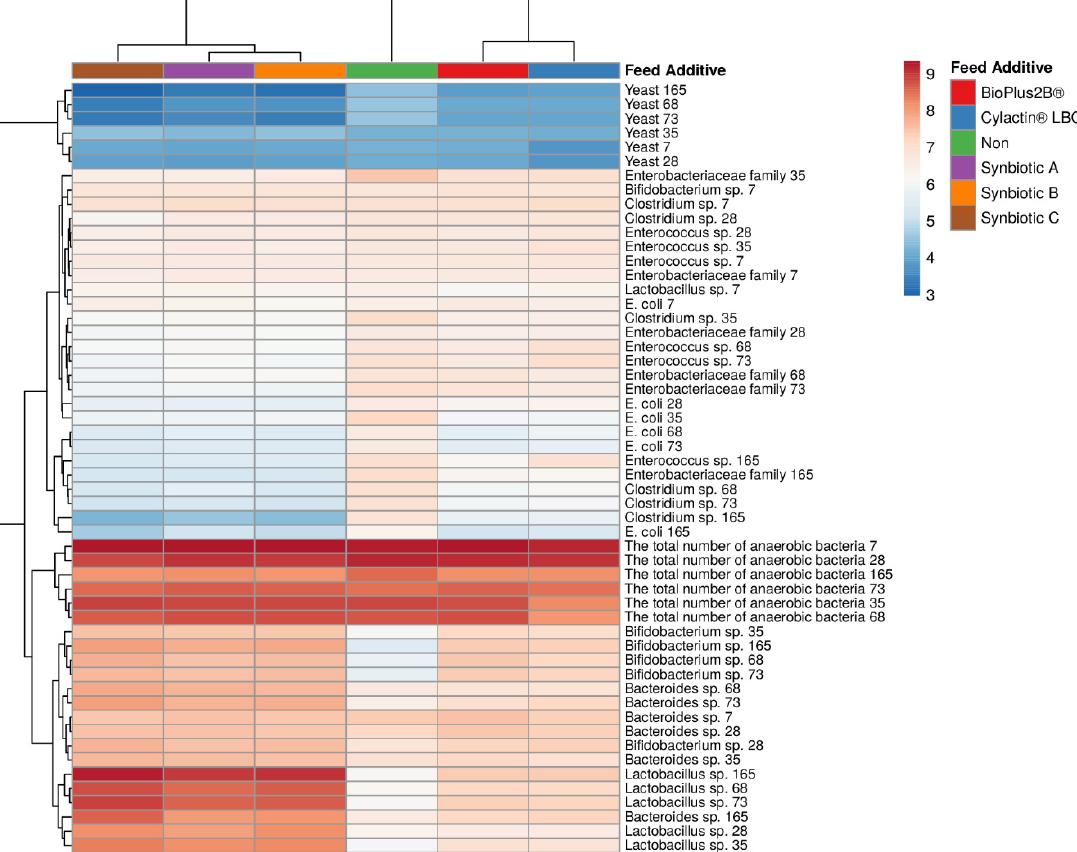
Figure 2. Heatmap presents changes in piglets’ fecal microbiota in correlation with the administrated feed additives. Columns correspond to the preparations used to modify piglets feed (directly or indirectly), whereas rows are assigned to specific microorganisms and the day of piglets’ life when fecal samples were collected, namely, 7th and 28th (suckling piglets), 35th and 68th (weaned piglets), and 73rd and 165th (finisher pigs).